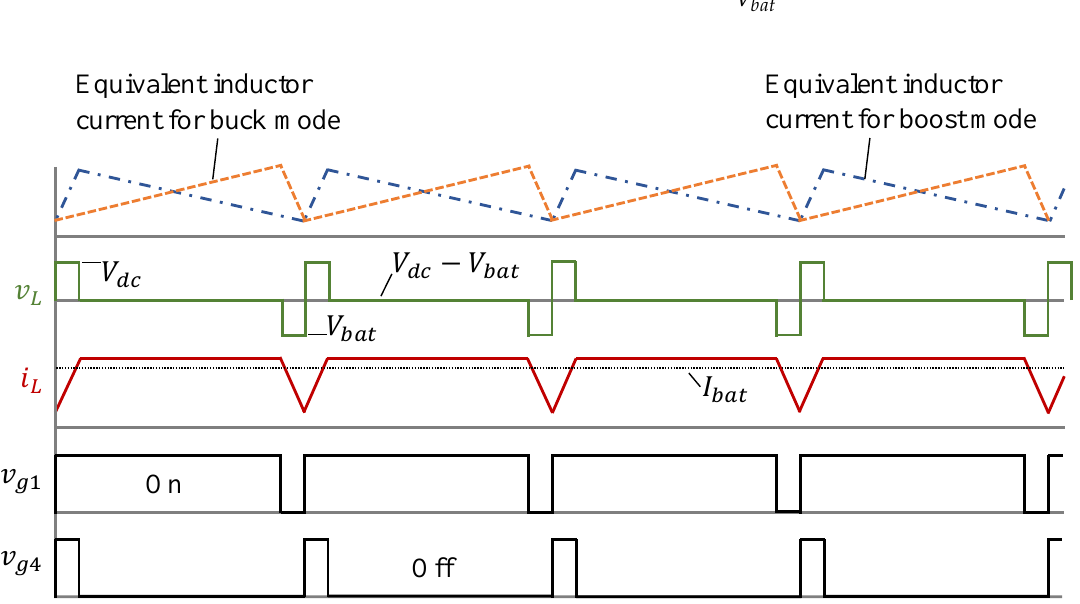
Figure 5. Characteristic of the inductor current and voltage in buck + boost